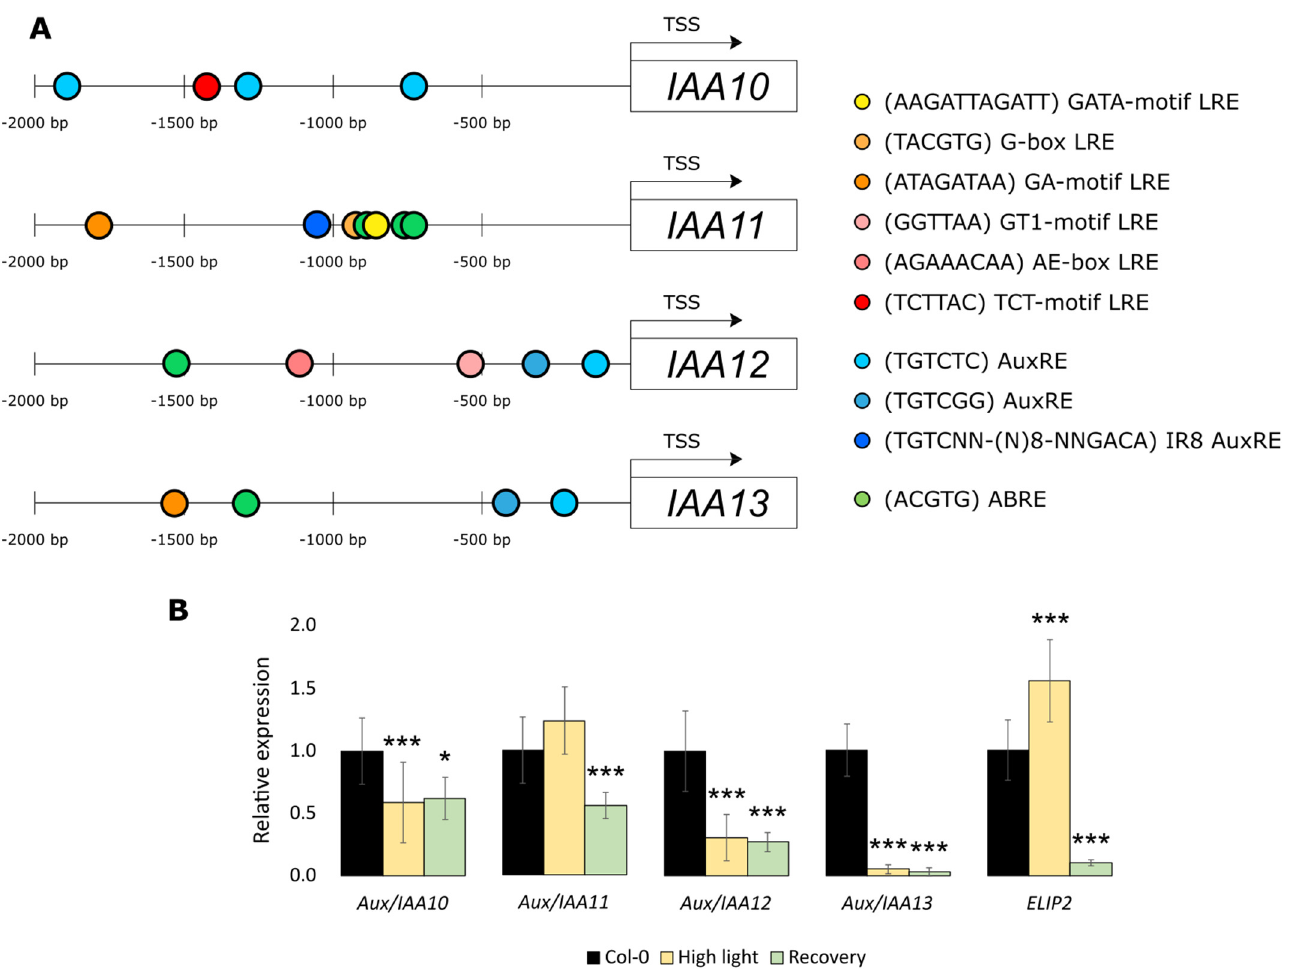
Figure 2. Promoter analysis and light induction of the Aux/IAA11 genetic clade. ( A ) Location of light responsive elements (LREs), auxin responsive elements (AuxREs), and abscisic acid responsive elements (ABREs) in promoter sequences 2000 bp upstream from the translation start site (TSS) of Aux/IAA10 , Aux/IAA11 , Aux/IAA12, and Aux/IAA13 genes. ( B ) Expression of the Aux/IAA11 phylogenetic clade in response to high light stress. Relative gene expressions were calculated and normalized with UBIQUITIN-PROTEIN LIGASE 7 ( UPL7 ) and YELLOW-LEAF-SPECIFIC GENE 8 ( YLS8 ) as references, using Relative Expression Software Tool (REST 2009) (n = 6, * p < 0.05; *** p < 0.001). Error bars represent the standard deviation.